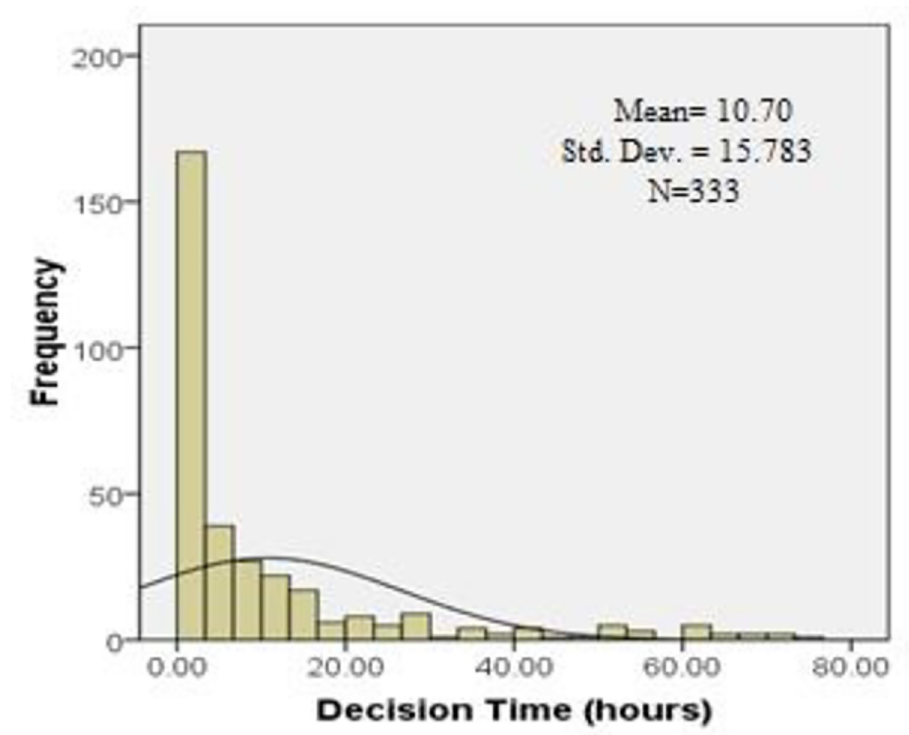
Fig 2. Histogram showing distribution of decision time with right